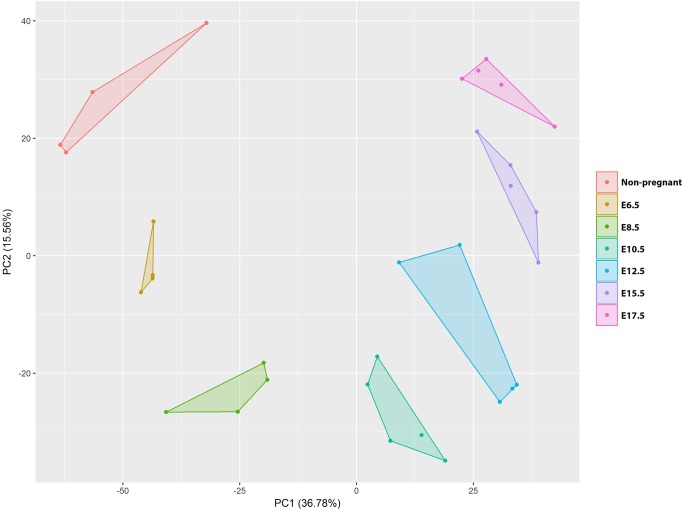
Principal component analysis (PCA).PCA of the quantile normalized dataset consisting of 32 mouse uterine RNA samples. The colours represent different embryonal days at which the tissue was harvested. % of total variance for PC1 and PC2 is indicated between brackets.